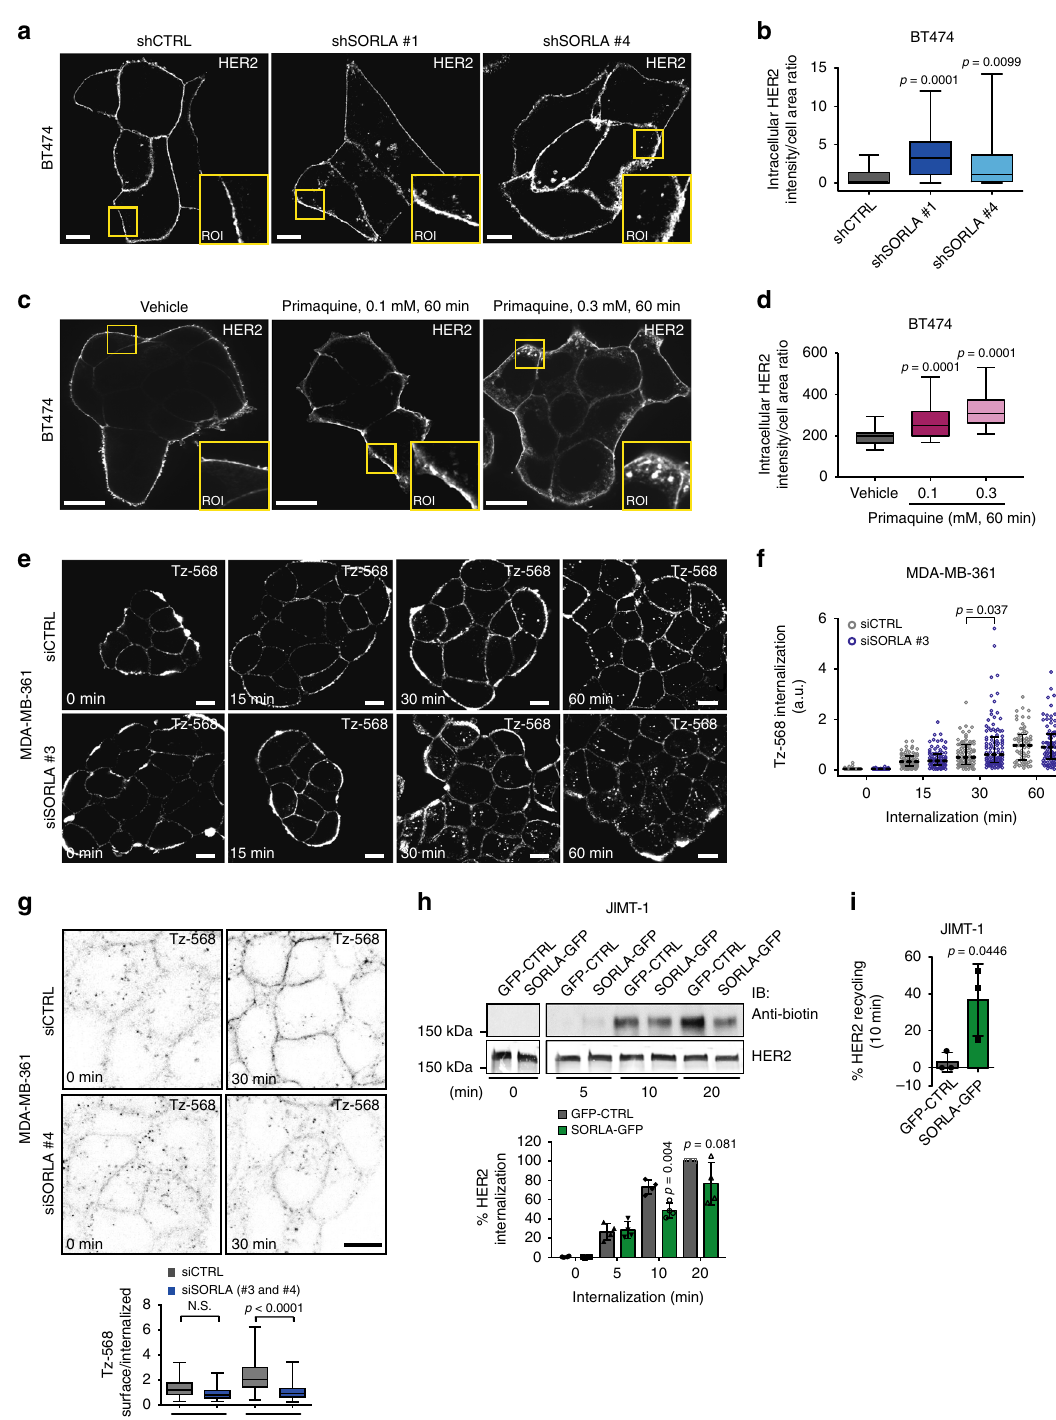
proportion (38%) of HER2-ampli fi ed breast cancers express moderate to high SORLA, indicating that HER2-ampli fi ed breast cancers fall into two subtypes with respect to SORLA positivity (Fig. 5a). However, in spite of a lack of overall correlation between HER2 ampli fi cation and SORLA expression in breast cancer, high SORL1 expression appears to predict poor relapse- free and overall survival speci fi cally within HER2-ampli fi ed breast cancer patients (Fig. 5b) according to the in silico biomarker assessment tool 38 (http://kmplot.com), which interrogates large NATURE COMMUNICATIONS| (2019) 10:2340